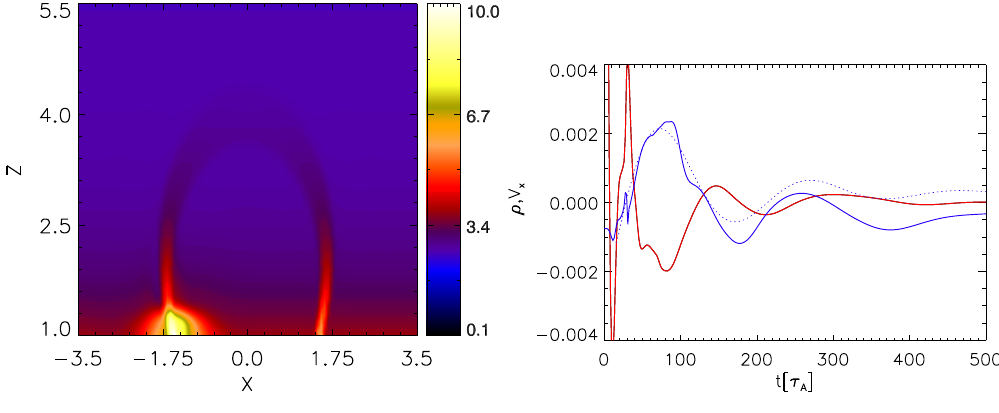
Fig. 5. Left panel: Mass density profiles in x − z plane (for y = 0) at the beginning of simulation, when the pulse appears. Spatial coordinates are measured in units of L s . Right panel (from Ofman and Selwa, 2009): Time-signatures of the mass density (red line) and the x -component of velocity (blue line) at the loops apex. The dotted line shows the fit used to determine the period and normalized damping time. The density is measured in units of % 0 and velocity in units of V A0 .